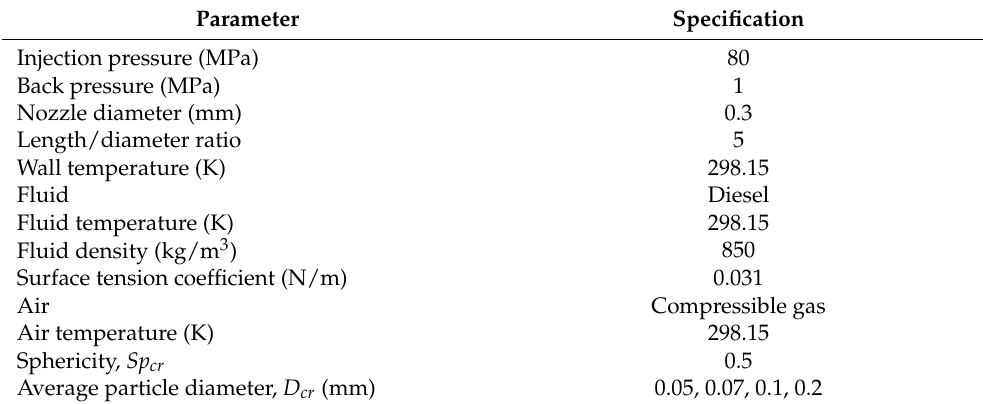
Table 1. Model physical